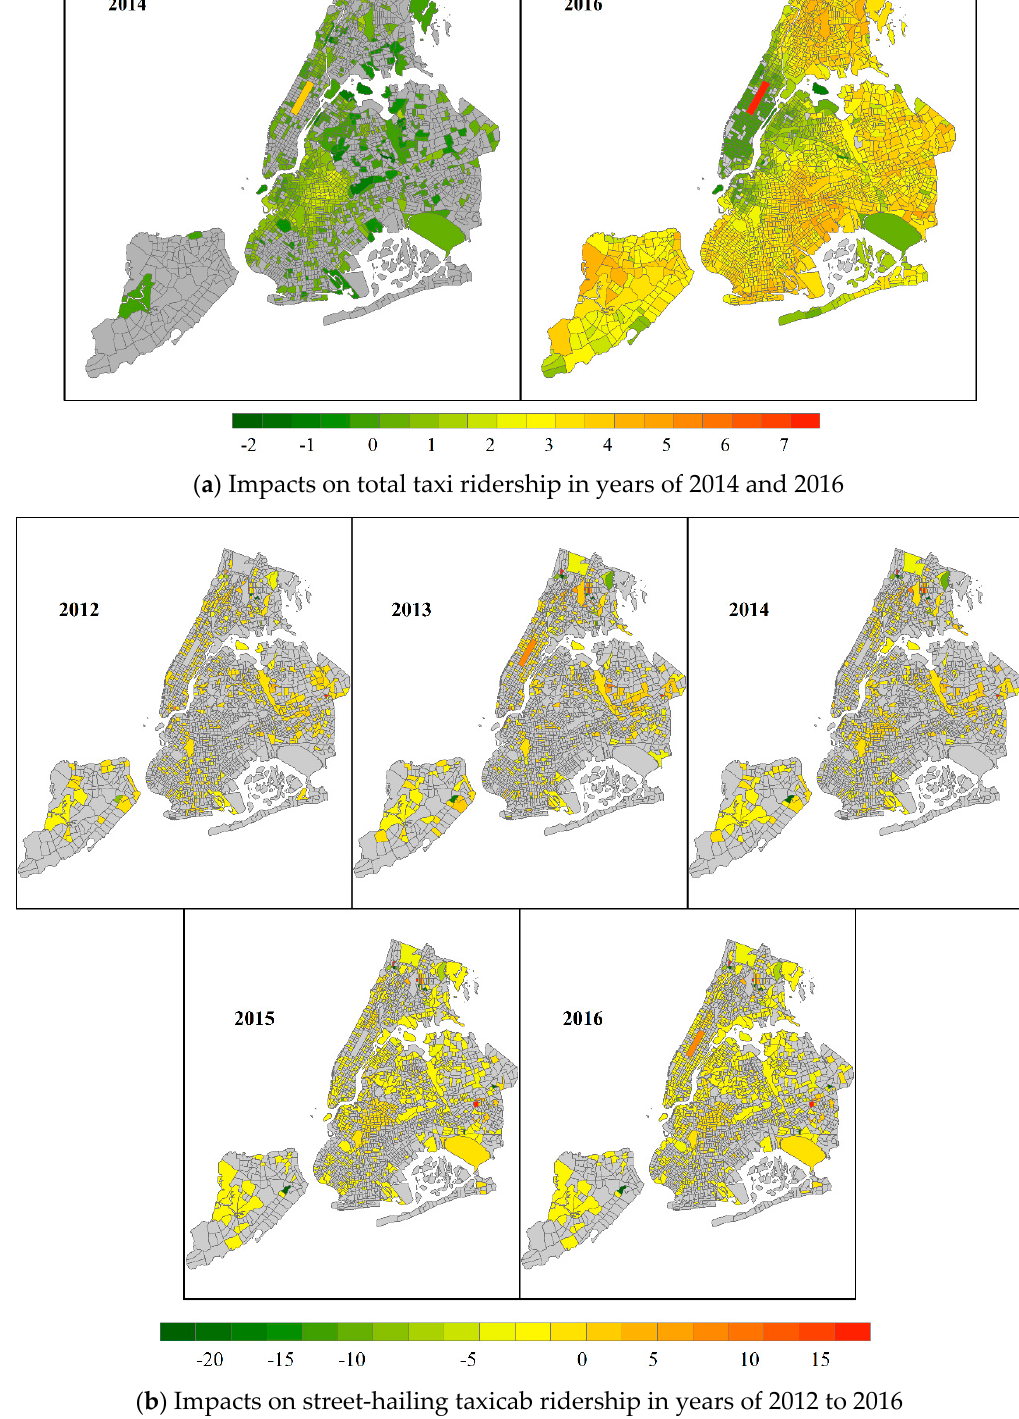
Figure 3. Impacts of presence of app-based taxi services. (Note grey regions mean the corresponding impacts are statistically insignificant.).